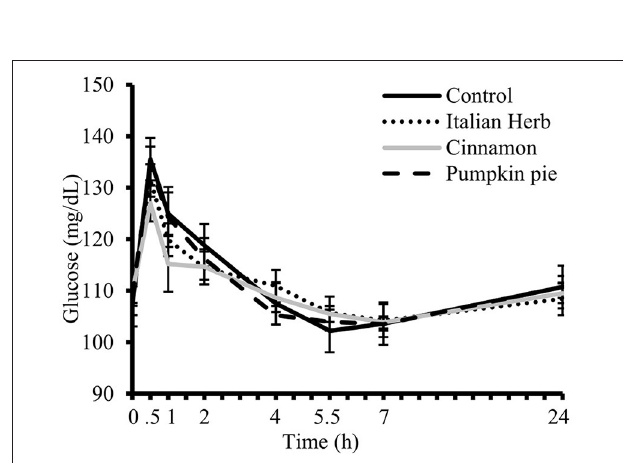
FIGURE 4 | Postprandial plasma glucose concentrations over 7h after consuming high-fat and high-carbohydrate (HFHC) challenge test meals with and without addition herbs and spices (H/S) followed by fasting 24h plasma glucose concentration ( n = 23). Main effect of meal ( P = 0.17), time ( P < 0.0001). Data are means ± standard error of mean. PROC MIXED (SAS Institute, Inc., Cary, North Carolina) was used for repeated